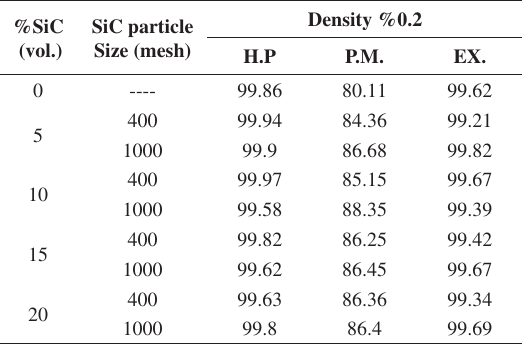
Table 2. Al-SiC composite densities measured by Archimedes method. %SiC